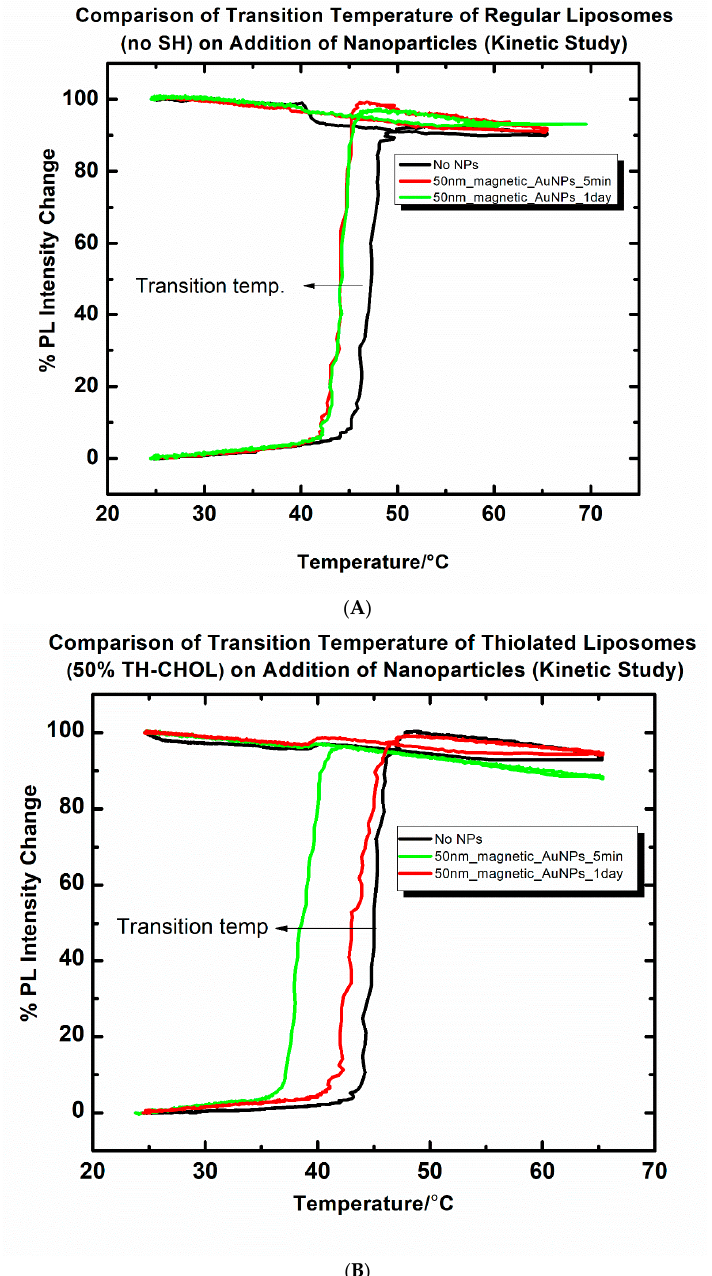
Figure 5. ( A ) Kinetics of interactions of 50 nm magnetic AuNPs with regular liposomes. ( B ) Kinetics of interactions of 50 nm magnetic AuNPs with thiolated liposomes (Th-Chol 50%).